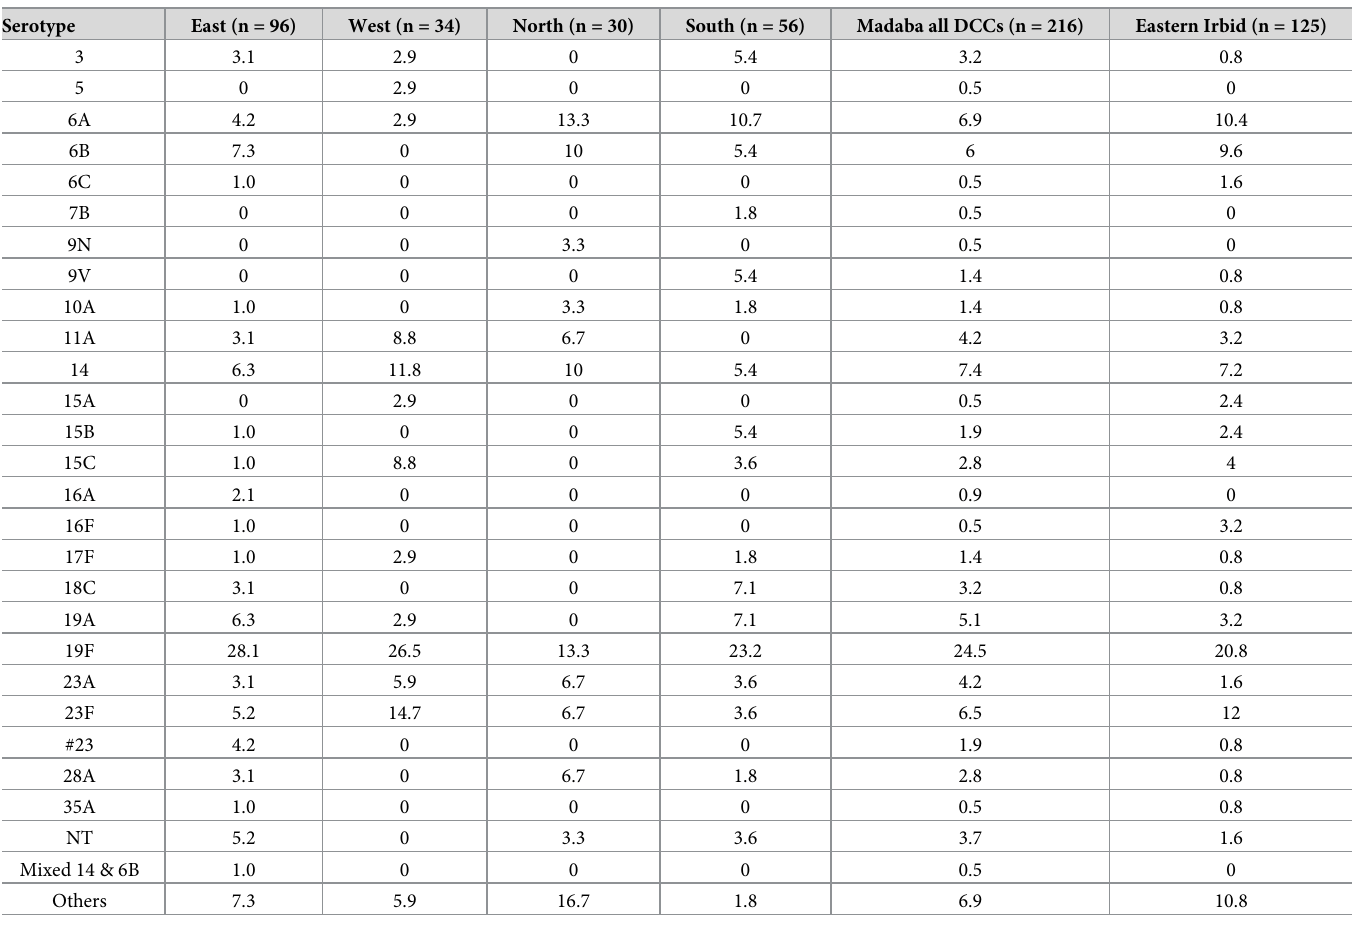
Table 4. Percentage of serotypes recovered from all DCCs for both winter